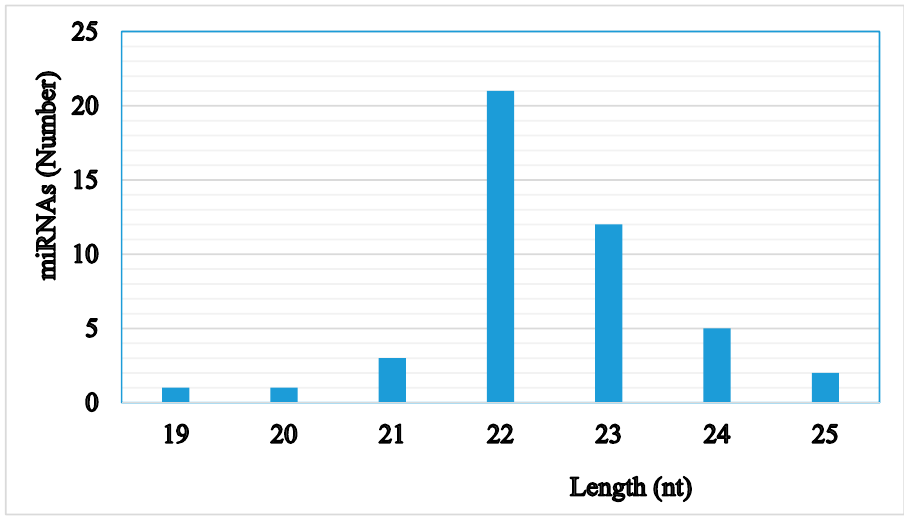
Figure 3. Size distribution (nucleotide length) of identified miRNAs from M. incognita .